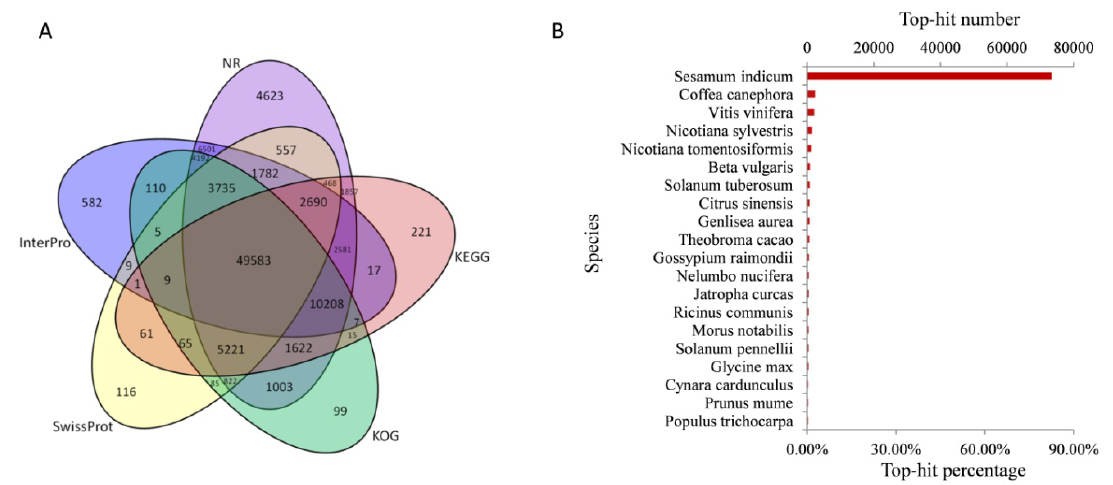
Figure 2. Characteristics of homology search of R. glutinosa unigenes. ( A ) Venn diagram of shared and unique unigenes in R. glutinosa . Annotation according to the nr, nt, Swiss-Prot, KEGG, COG, GO, and Interpro databases; ( B ) number and percentage of unigenes matching the 25 top species using BLASTx in the nr database.